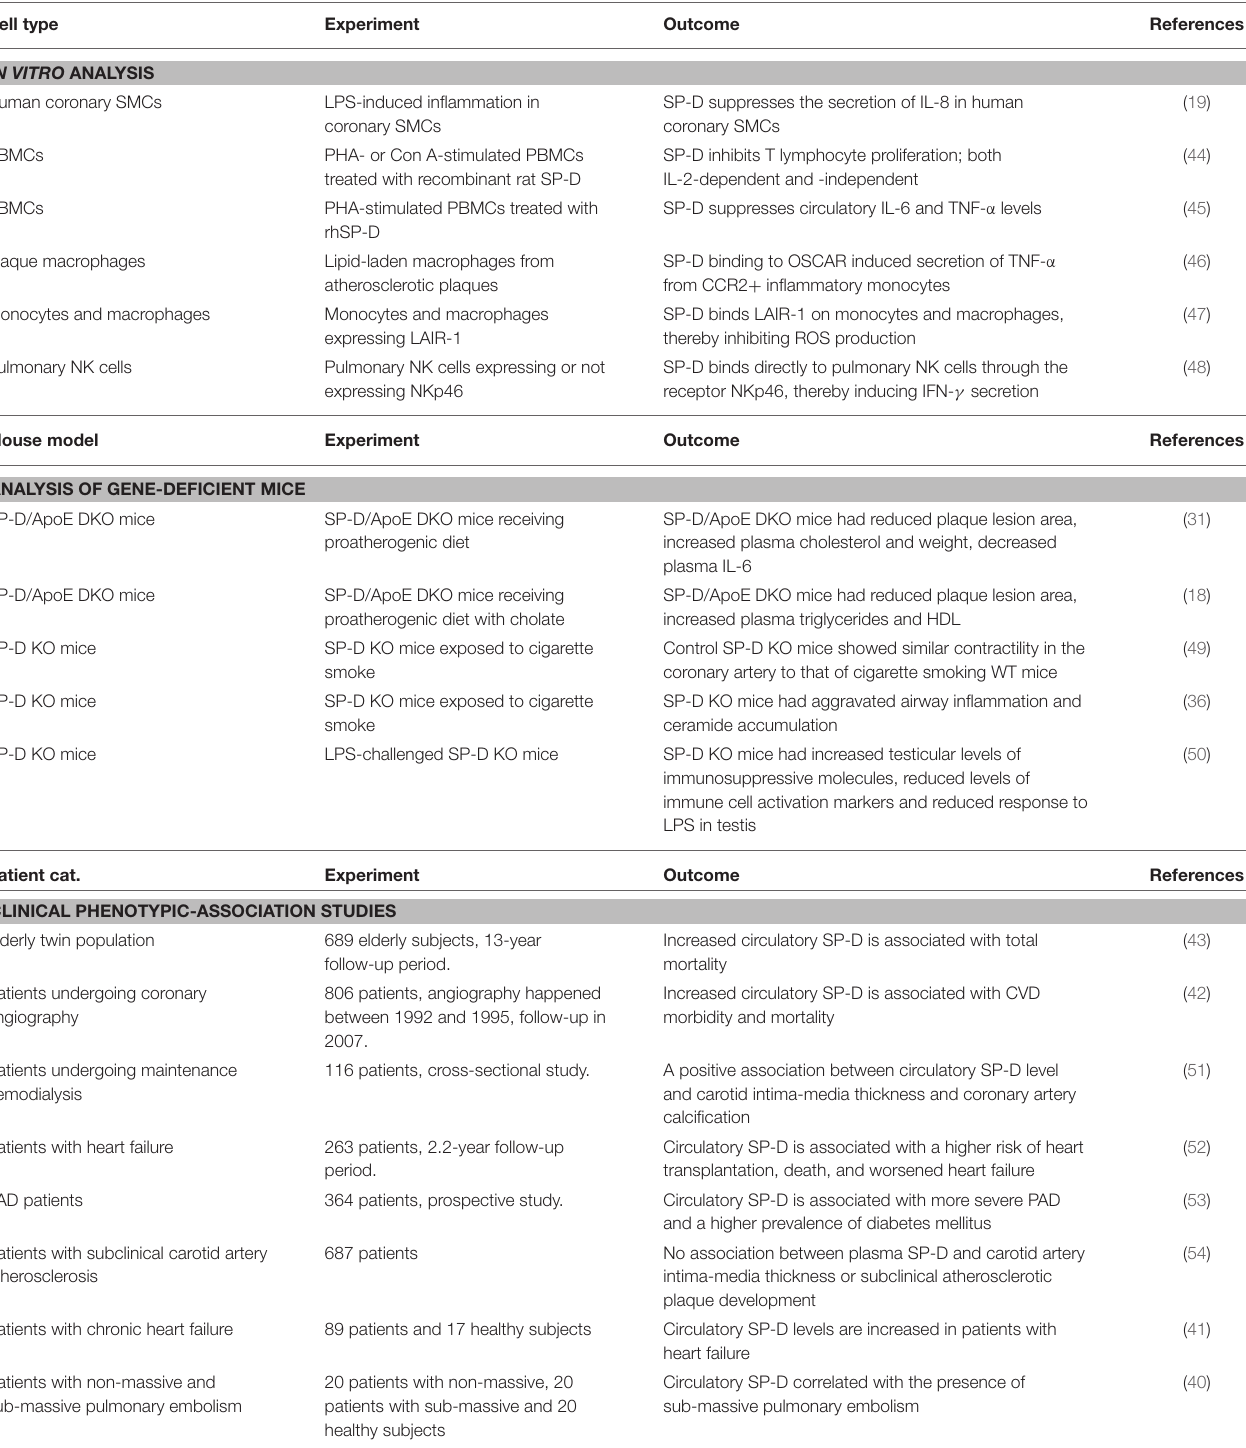
TABLE 1 | SP-D-mediated effects related to